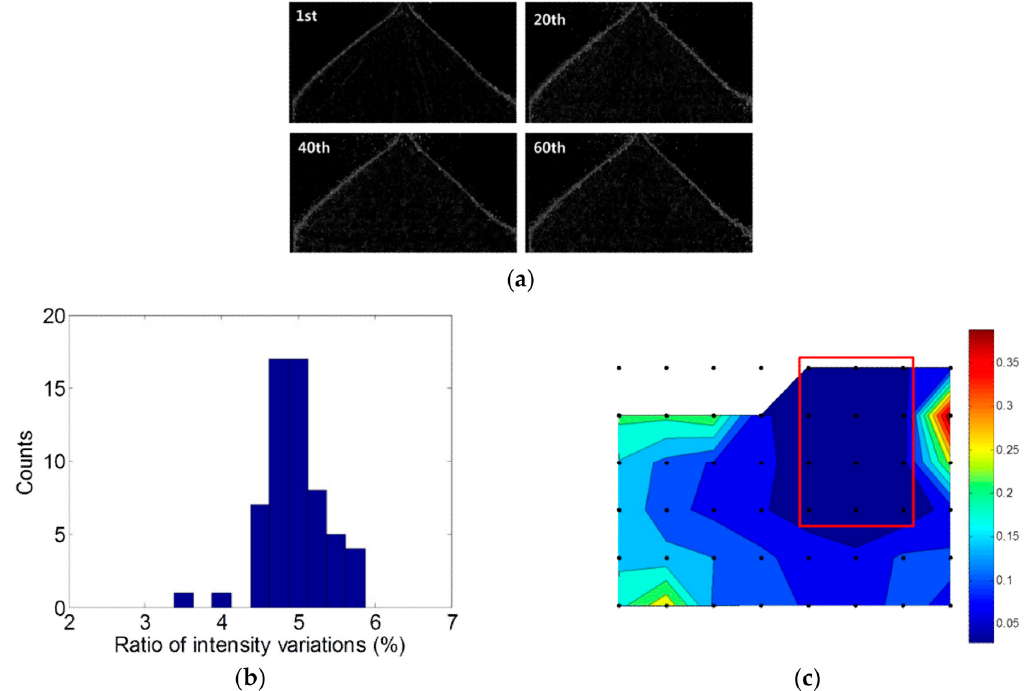
Figure 7. Stability analysis of spray patterns at the electric field of 15 kV and the pneumatic pressure of 0.0 bar. ( a ) Example of the 1st, 20th, 40th and 60th distributions of the intensity di ff erences. The display range of the gray-scale from black to white was set from 0 to 30 to show the di ff erences clearly; ( b ) histogram of stabilities obtained from sixty intensity di ff erences; ( c ) contour map in that the stabilities of spray patterns are displayed by being matched with the array of images in Figure 3 using dots. The boundary of the stable spray processes was indicated by the red lines when the criteria of the stability measure was set to